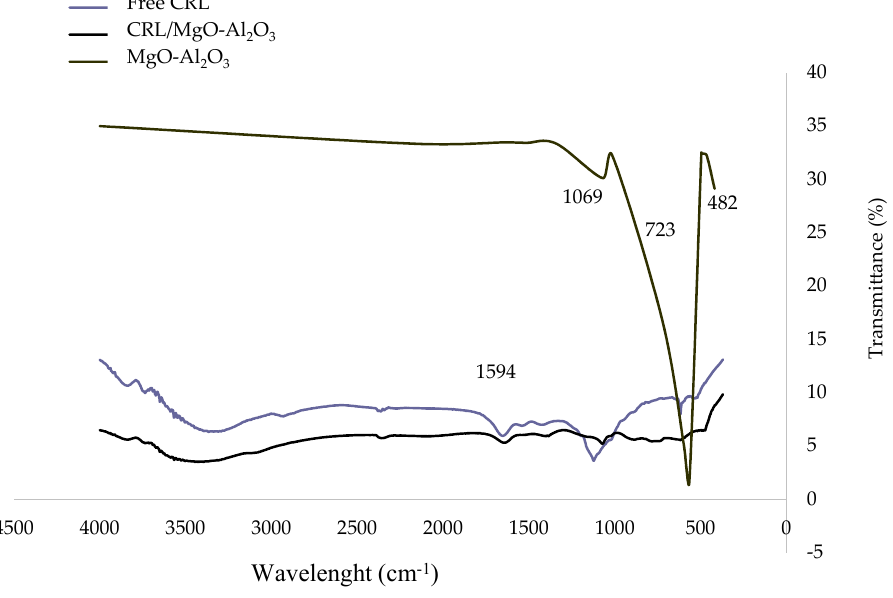
Figure 11. Fourier transform infrared spectra of the support (Al 2 O 3 ), adsorbed metal oxide (MgO -